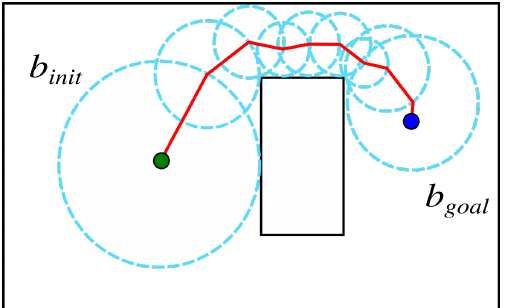
Figure 1. Solved path planning. Extracted rosary and found path (red